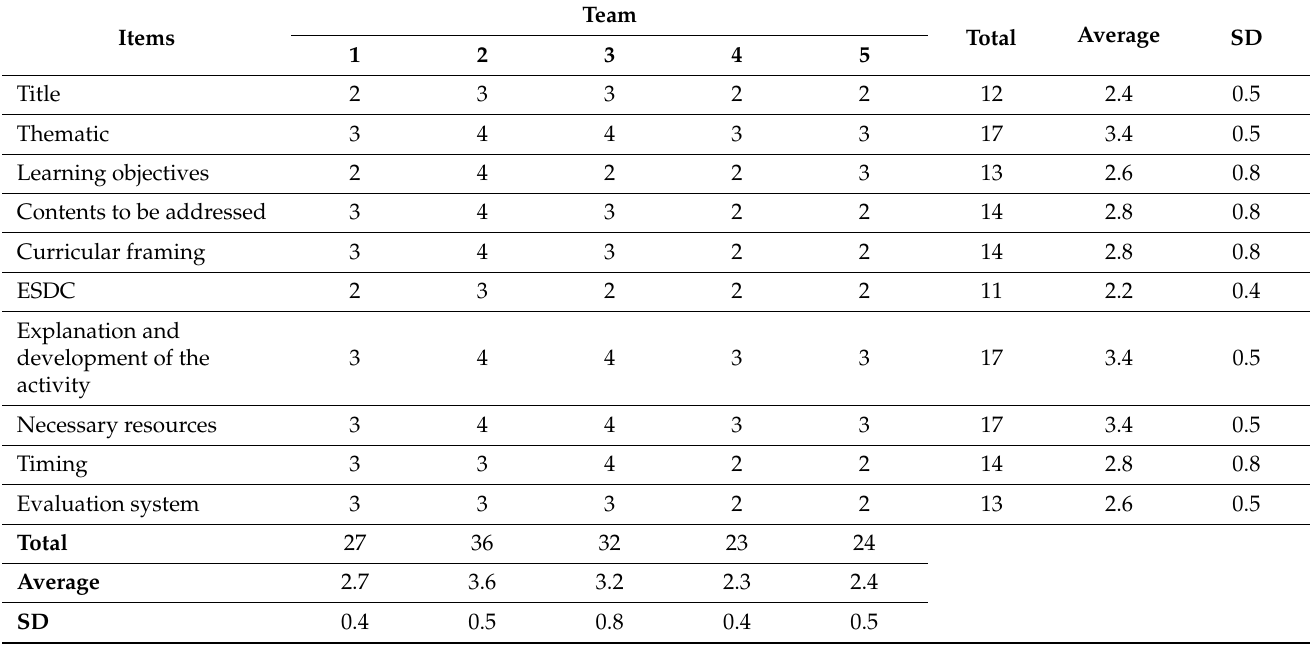
Table 2. Results of analysis and evaluation didactic